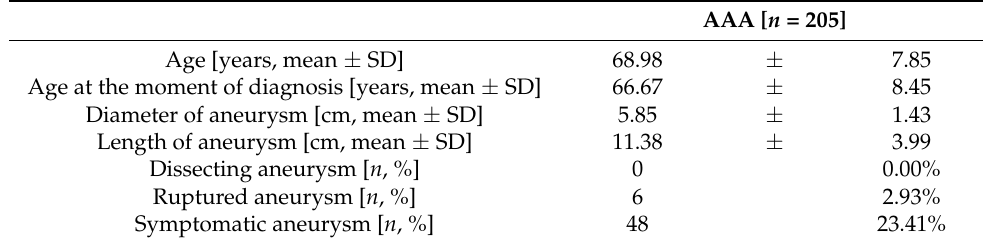
Table 2. Morphological description of aneurysms in the study